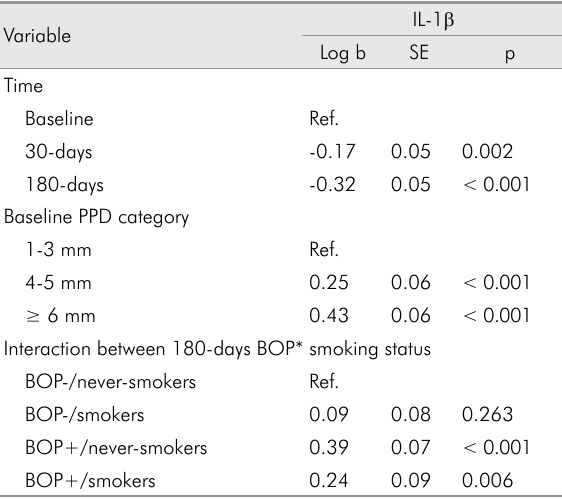
Table 3. Multivariate GEE model of log concentration of IL-1 β including the interaction between BOP at 180 days and smoking